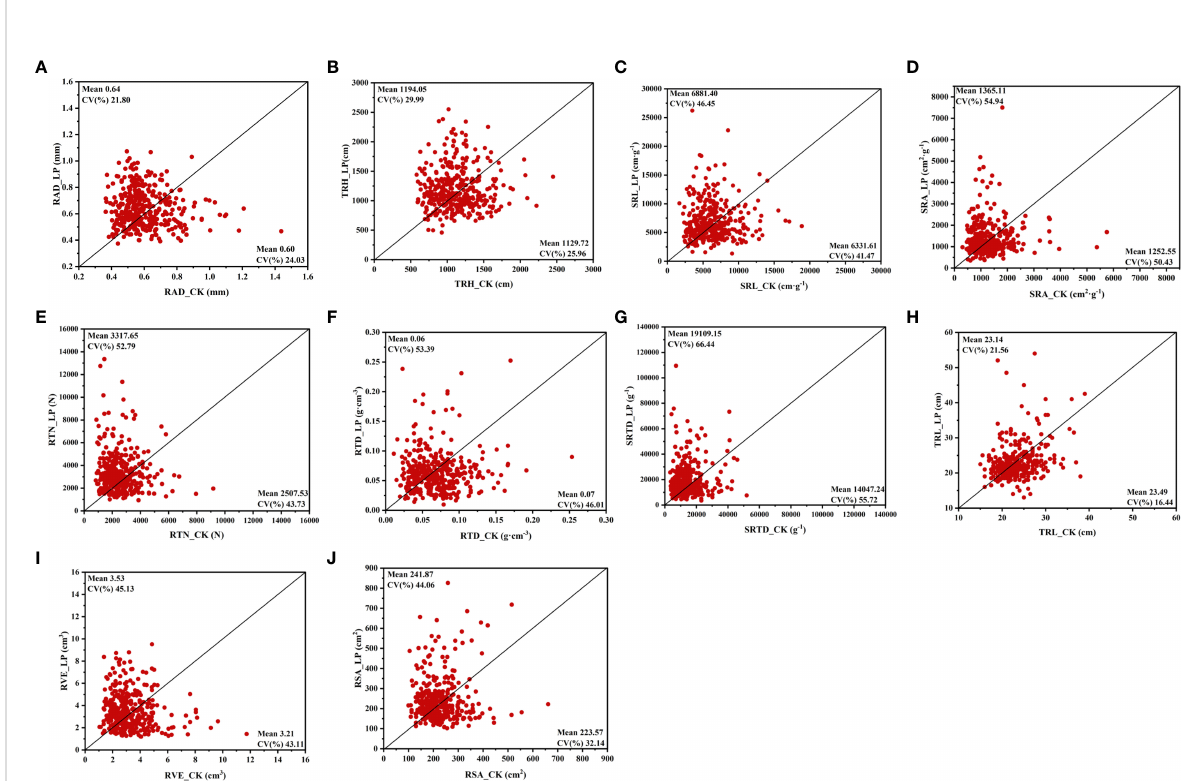
FIGURE 2 Variation in root morphological trait of 384 cotton plant accessions exposed to different Pi supplies for 28 days. (A) root average diameter (RAD), (B) total root length (TRH), (C) speci fi c root length (SRL), (D) speci fi c root area (SRA), (E) root tips number (RTN), (F) root tissue density (RTD), (G) speci fi c root tips density (SRTD), (H) tap root length (TRL), (I) root volume (RVE), (J) root surface area (RSA). The horizontal line in the picture is normal nutrition conditions (CK), and the vertical line is low phosphorus